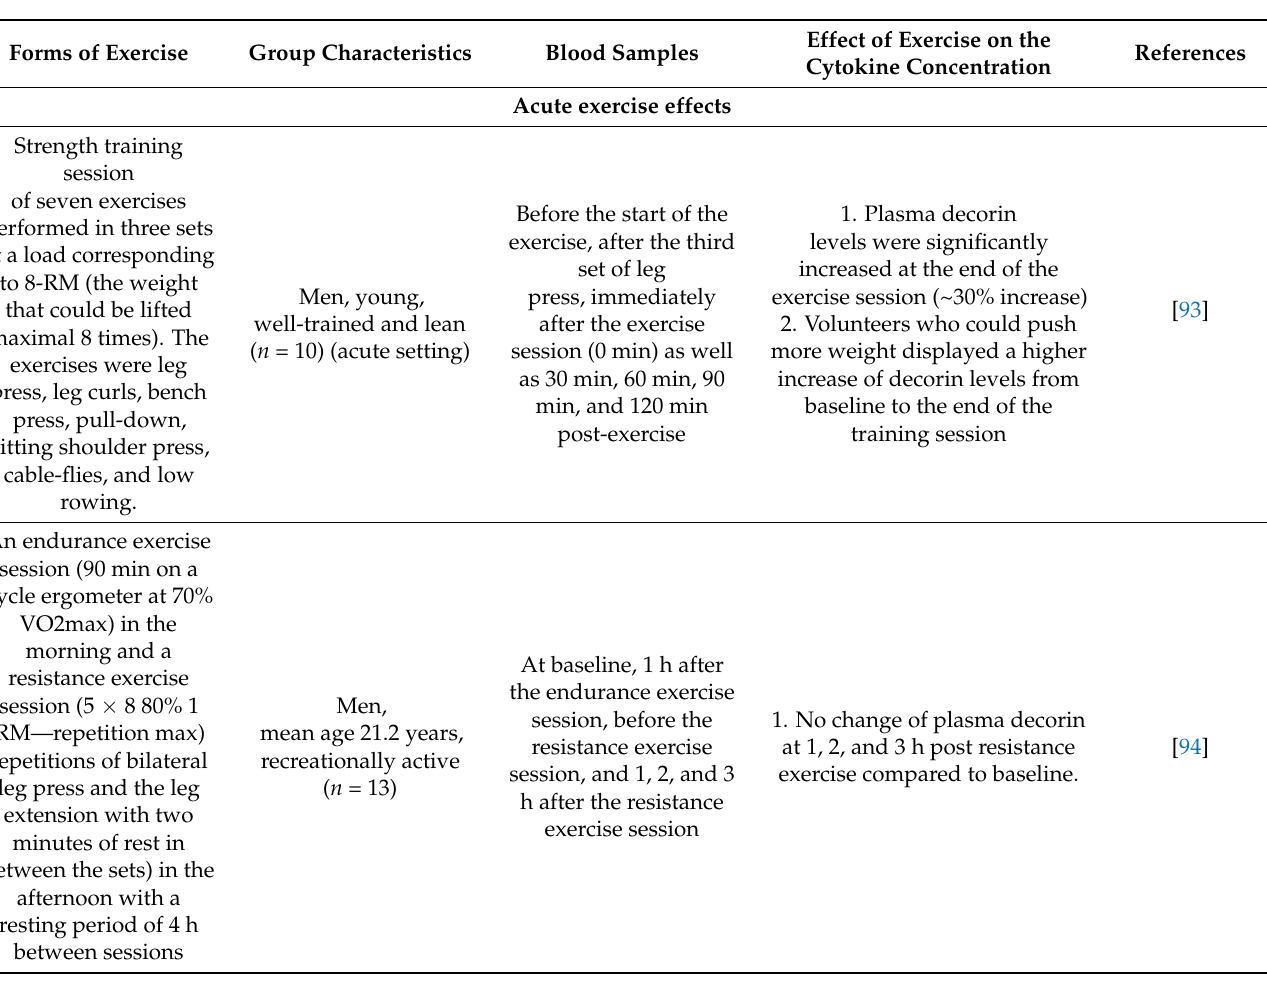
Table 4. Effects of exercise on